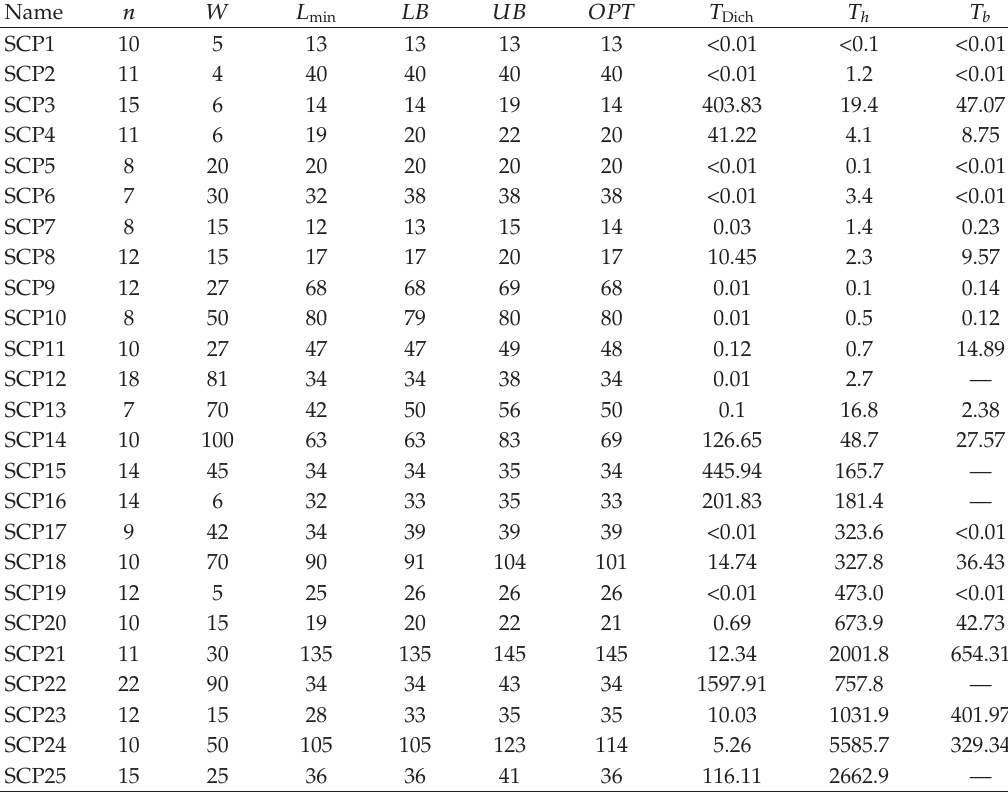
Table 2: Results of exact algorithms on Hifi’s